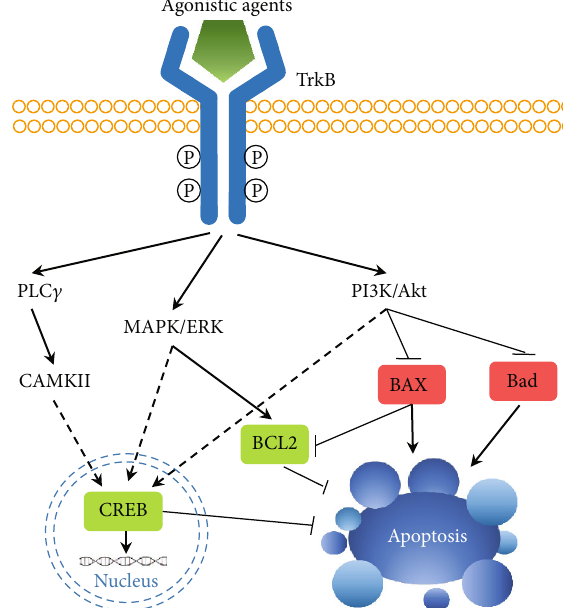
Figure 3: Activation of the TrkB receptor by speci fi c agonists triggers downstream signaling cascades to induce transcription and suppress apoptosis. Upon binding to the TrkB receptor, speci fi c agonistic agents induce the formation of a TrkB homodimer and autophosphorylation of the intracellular tyrosine kinase domains, as well as the activation of the PLC γ (phospholipase C gamma), MAPK/ERK, and PI3K/Akt signaling pathways. While the latter two pathways suppress apoptosis by interacting with apoptosis-regulating proteins, such as BCL2, BAX, and Bad, all three pathways activate CREB-mediated transcription of prosurvival genes and thus protect neurons from